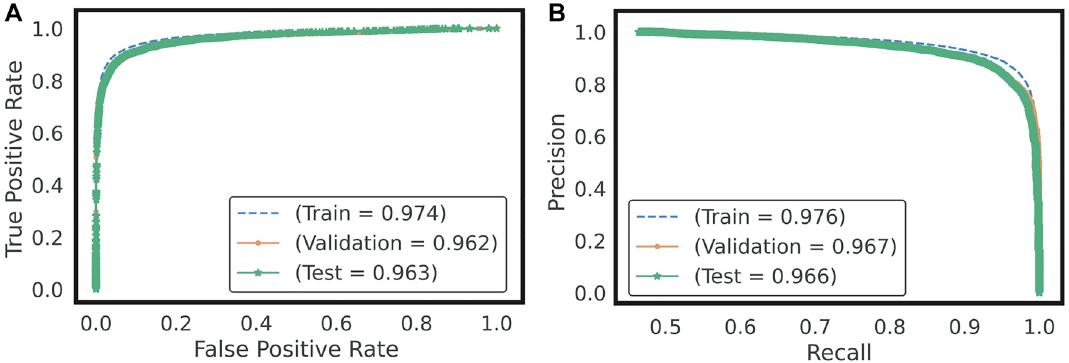
Figure 9: ROC curves and Precision-recall for the test data set. (A) ROC and (B) PRC curves for the test dataset.